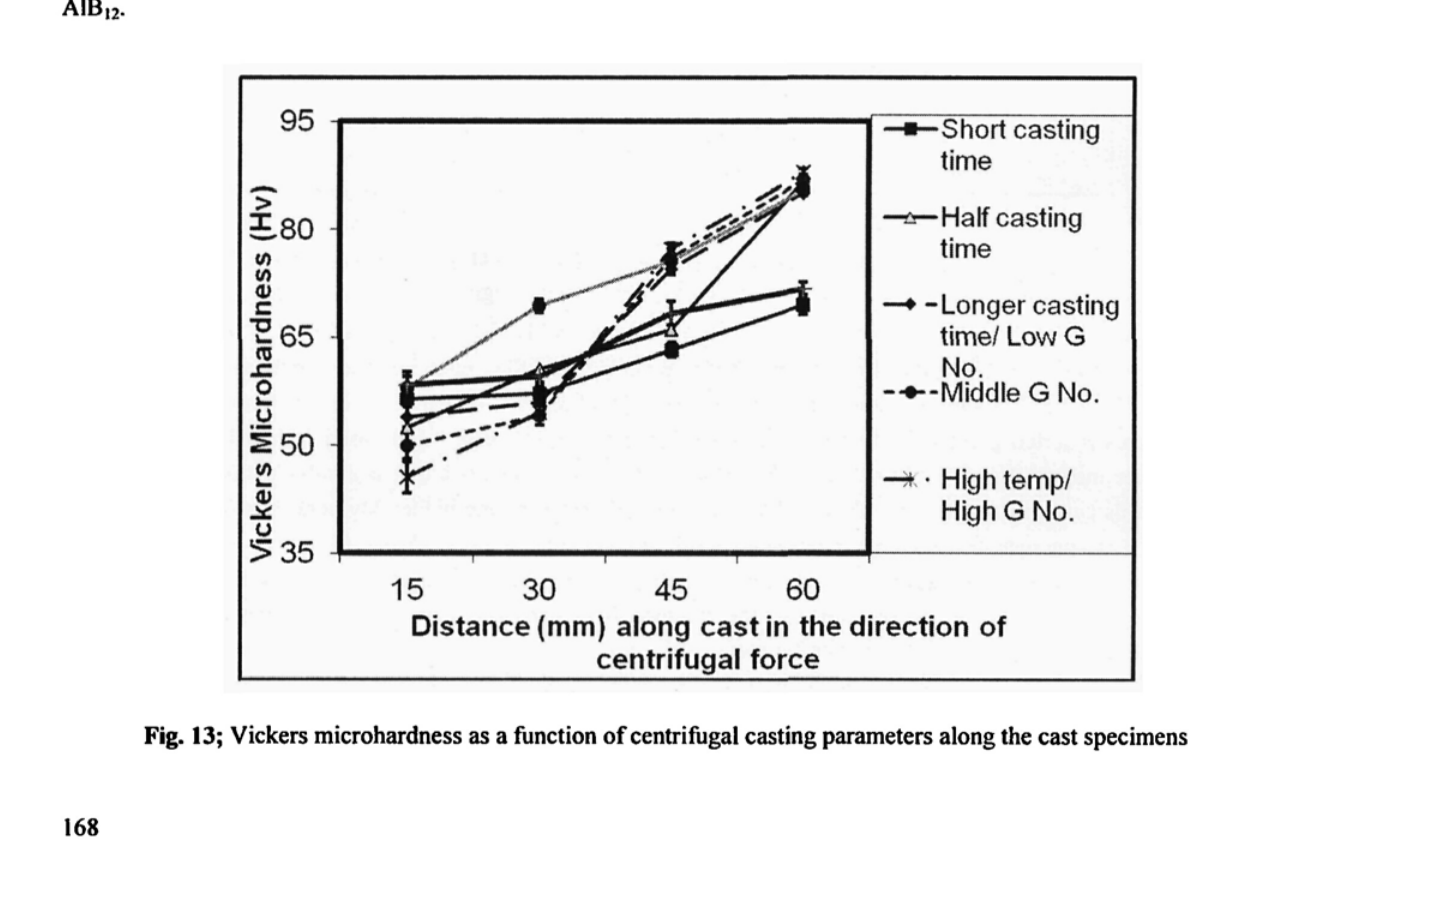
Fig. 13; Vickers microhardness as a function of centrifugal casting parameters along the cast specimens